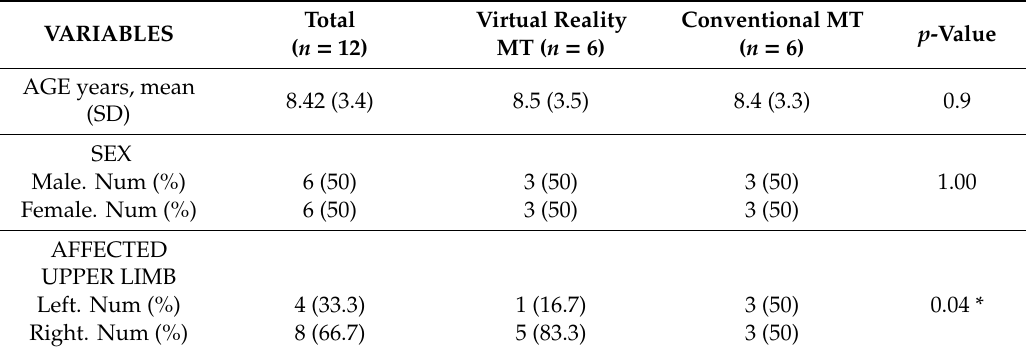
Table 3. Characteristics of the variables in the Virtual Reality MT and Conventional MT groups.